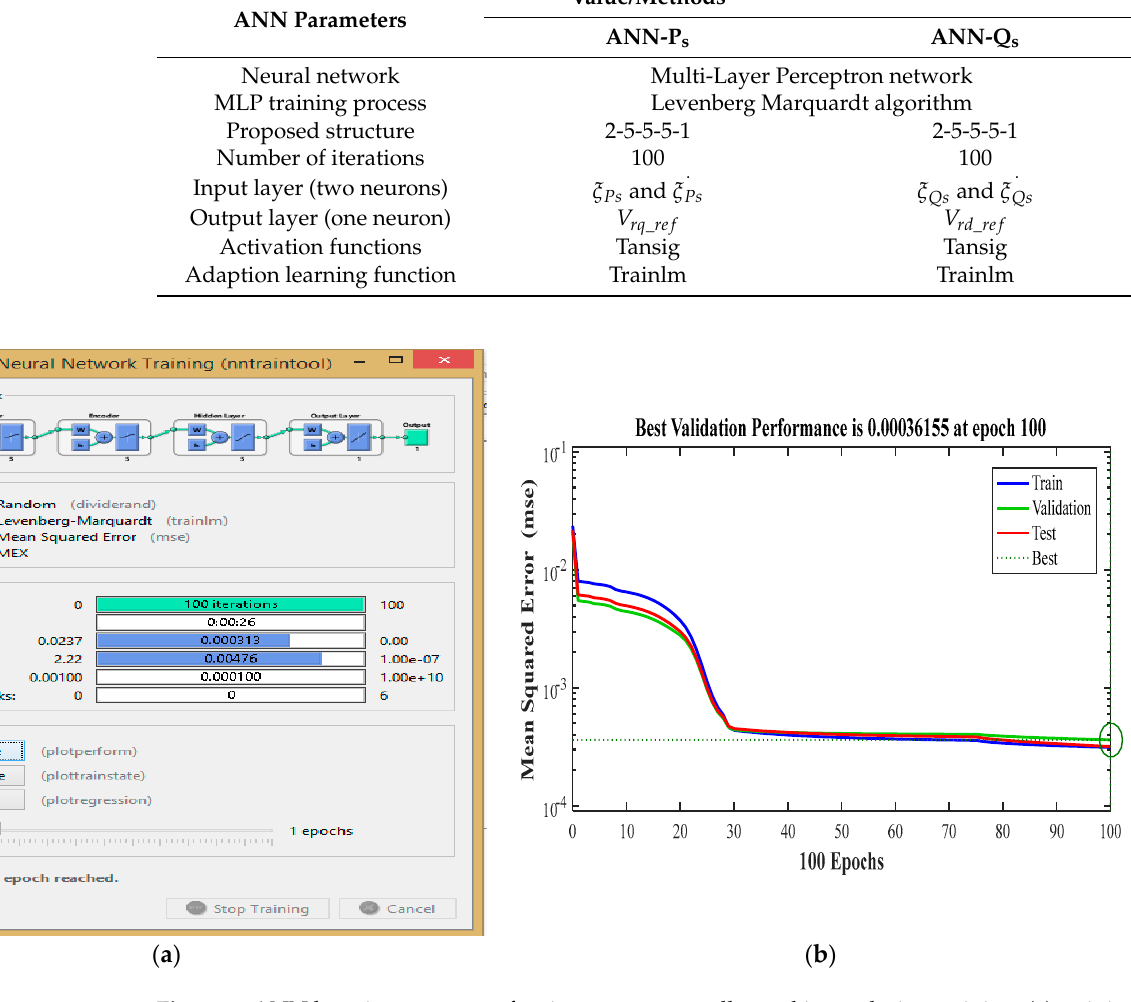
Figure 9. ANN learning progress of active power controller and its evolution training, ( a ) training GUI, ( b ) training performance based on MSE.